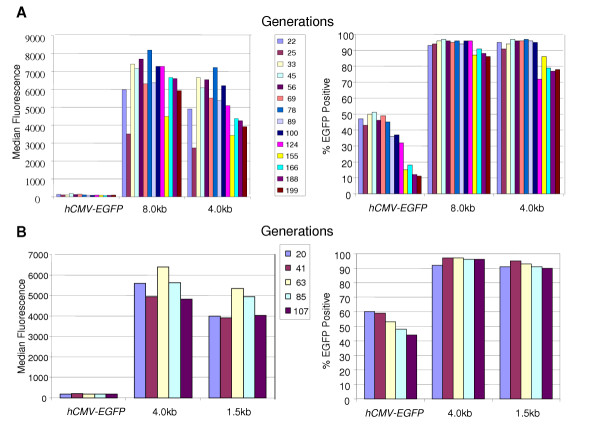
RNP CpG island fragments enhance the level and stability of EGFP expression in stably transfected CHO-K1 cells. A. Histograms representing the median fluorescence and percentage cells with detectable EGFP expression for CHO-K1 cells stably transfected with hCMV-EGFP, 8.0 kb RNP-EGFP or 4.0 kb RNP-EGFP. Following transfection pools of >100 transfectants were cultured continuously with drug selection for 107 generations and FACScan analysis conducted every few days. B. Histograms representing the median fluorescence and percentage cells with detectable EGFP expression for CHO-K1 cells stably transfected with hCMV-EGFP, 4.0 kb RNP-EGFP or 1.5 kb RNP-EGFP. Following transfection pools of >100 transfectants were cultured continuously with drug selection for 107 generations and FACScan analysis conducted every few days